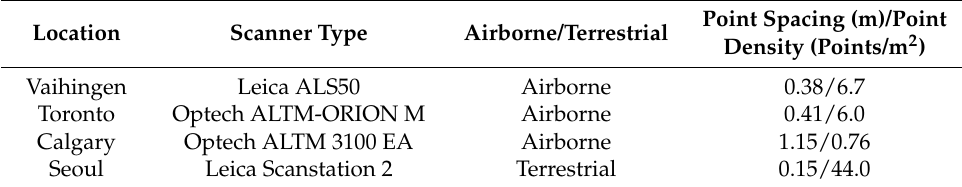
Table 2. Descriptions of Vaihingen, Toronto, and Seoul datasets.